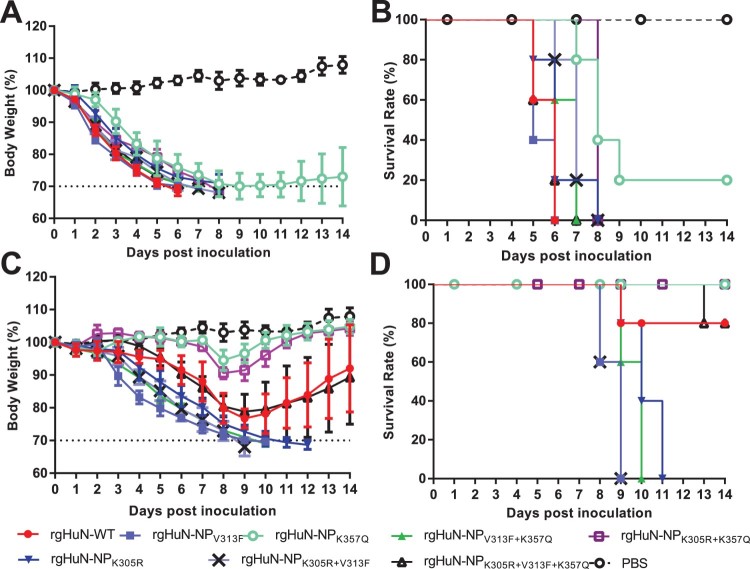
The pathogenicity of HuN mutants in mice. Mice (n = 5 per group) were inoculated with 106 TCID50 (A, B) or 104 TCID50 (C, D) of HuN mutants. Body loss (A, C) and death (B, D) were monitored for the 14 days post-inoculation. rgHuN-WT, wild-type virus carrying NP-305K, – 313V, and – 357K; rgHuN-NPK305R, with NP-305R, – 313V, and – 357K; rgHuN-NPV313F, with NP-305K, – 313F, and – 357K; rgHuN-NPK357Q, with NP-305K, – 313V, and – 357Q; rgHuN-NPK305R+V313F, with NP-305R, – 313F, and – 357K; rgHuN-NPK305R+K357Q, with NP-305R, – 313V and – 357Q; rgHuN-NPV313F+K357Q, with NP-305K, – 313F and – 357Q; rgHuN-NPK305R+V313F+ K357Q, with NP-305R, – 313F and – 357Q.